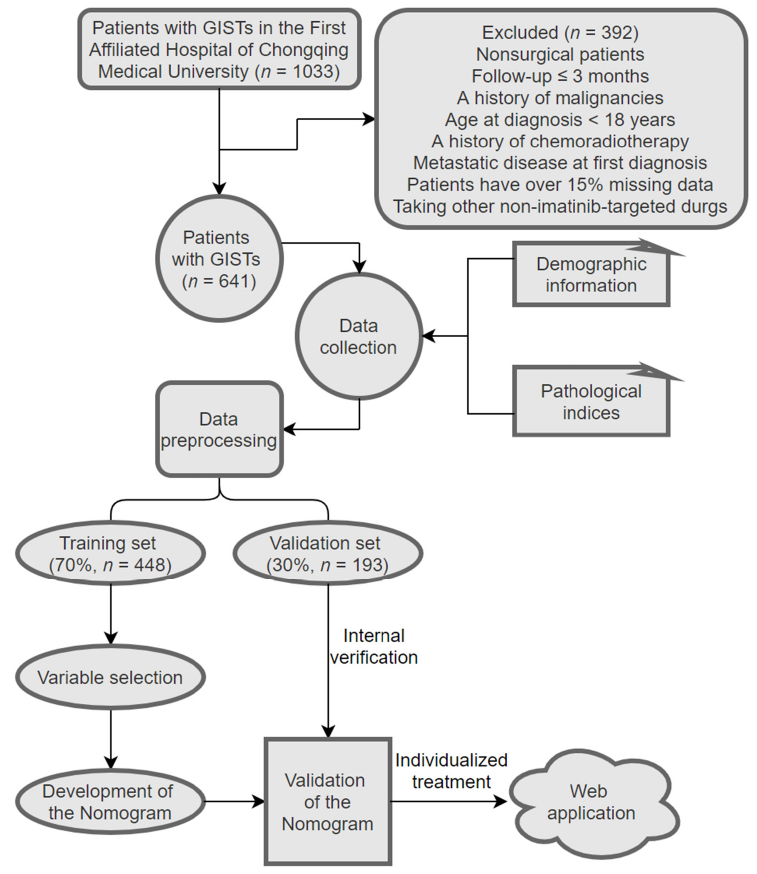
Figure 1. Patient selection process and study design.